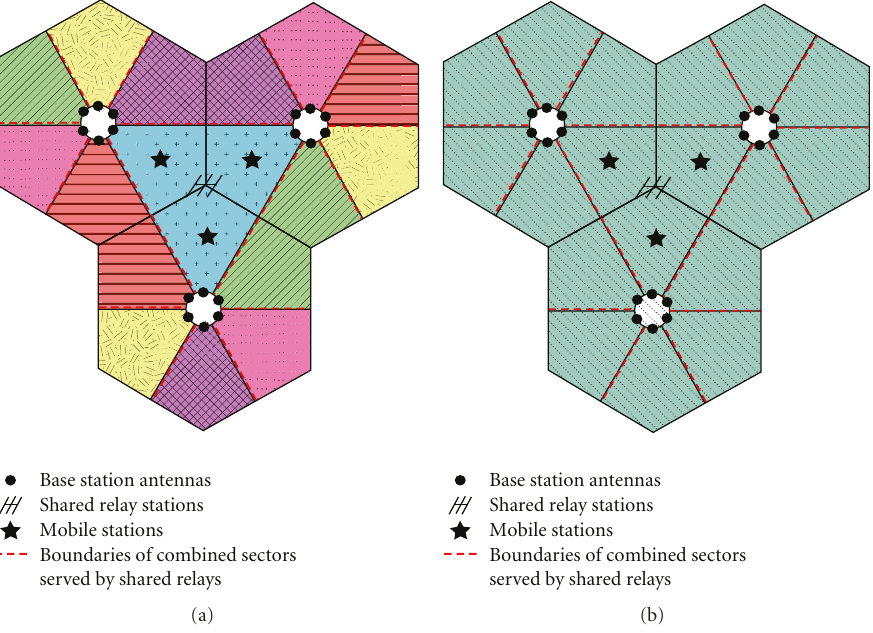
Figure 5: Models of systems using shared relays with (a) frequency reuse factor of 6 or (b) frequency reuse factor of 1.